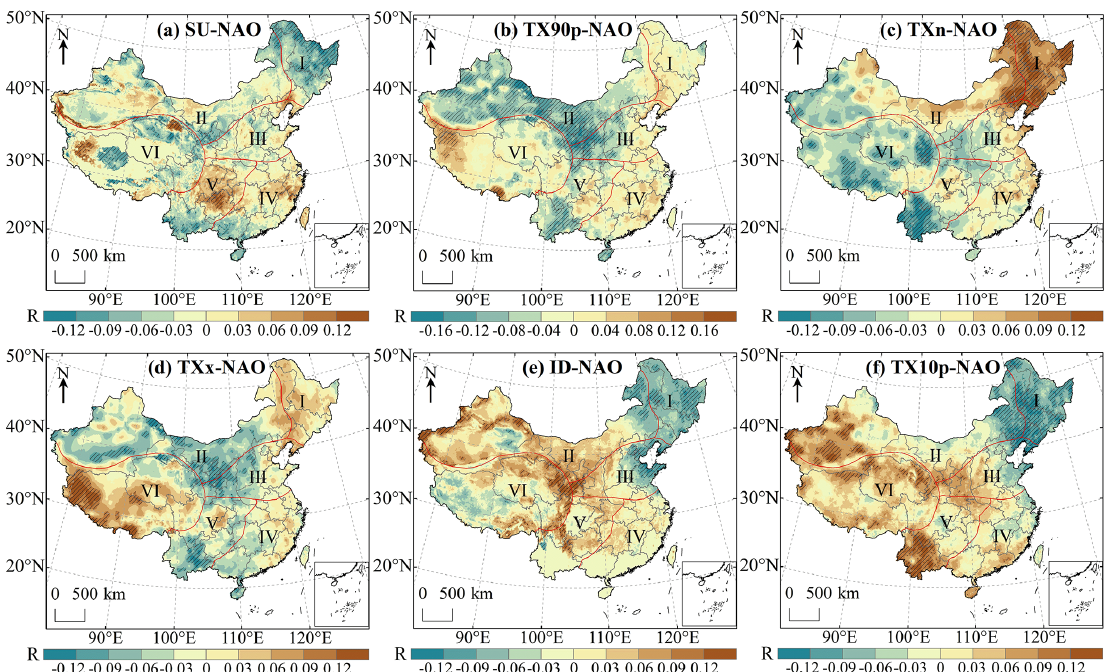
Figure 20. Correlation analysis between extreme temperature indices and NAO in China during 1979–2018. The shaded areas indicate correlations that are significant at the 0.05 level.